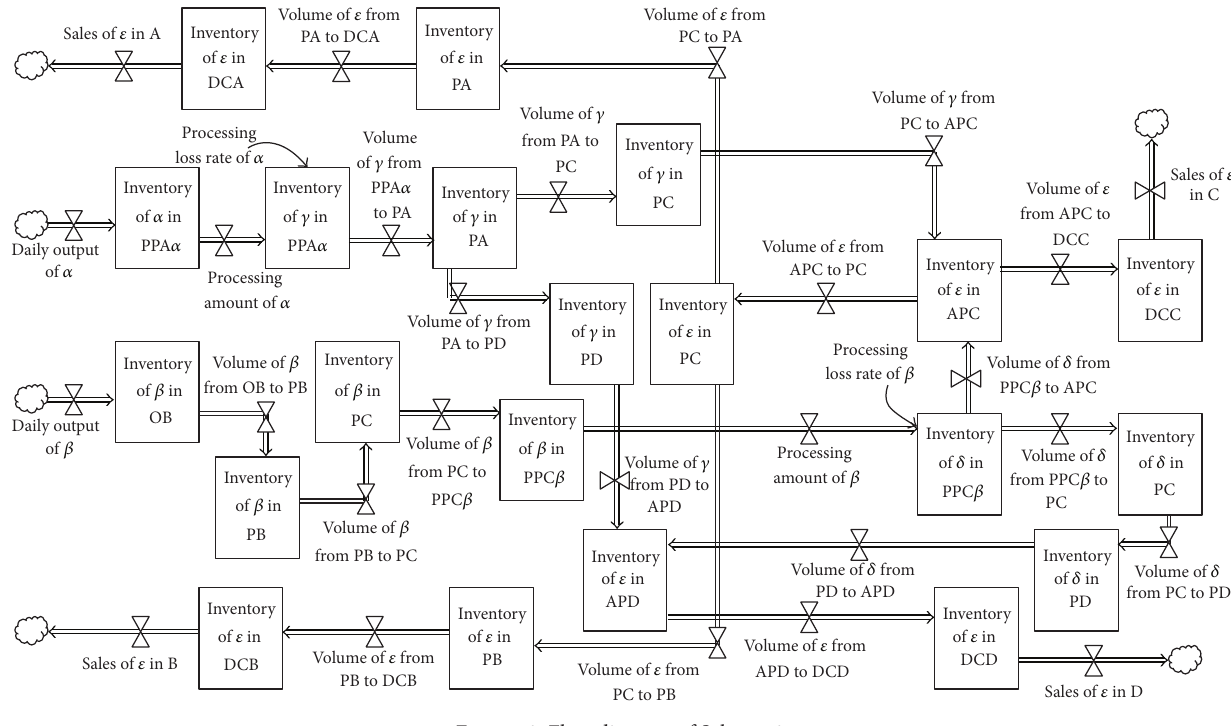
Figure 2: Flow diagram of Scheme 2 . Table 6: Setting of parameters in Scheme